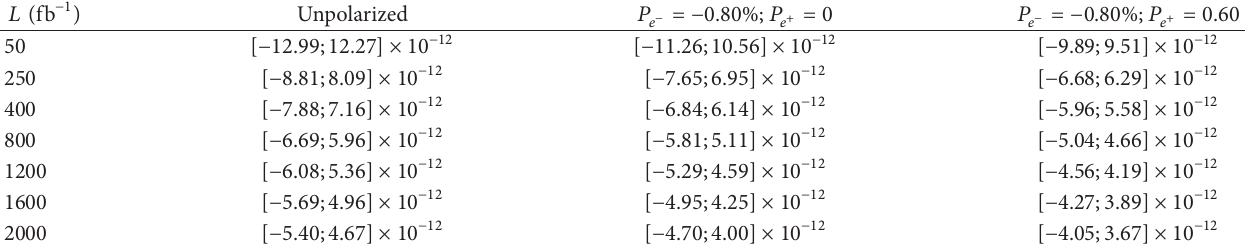
Table 4: Sensitivity of 𝑓 𝑆0 /Λ 4 at 95% CL for √𝑠 = 3 TeV in units of GeV −4 . 𝐿 ( fb −1 )